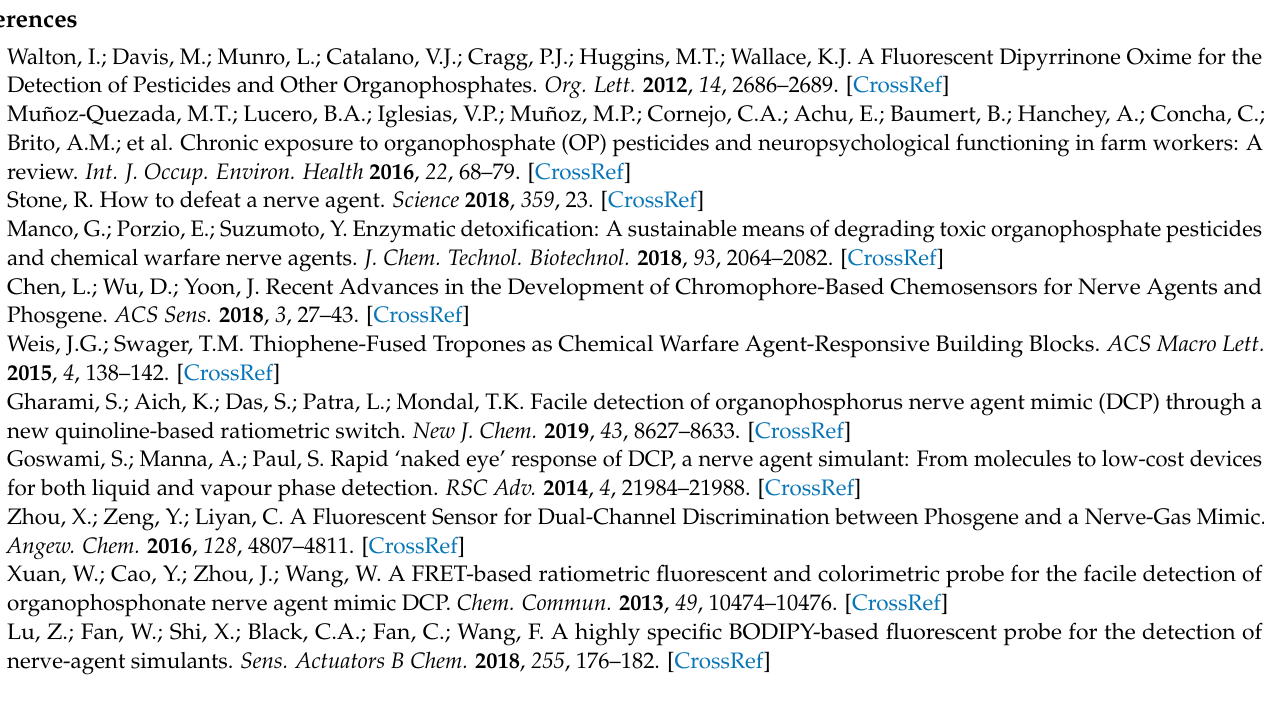
Table S1: Some reported work for the detection of DCP. Figures S1–Figure S3: Copies of 1 H, 13 C NMR, ESI-MS spectra of SWJT-4 . Figure S4: The changes of fluorescence in different solvents. Figure S5: The effect of pH on fluorescence intensity. Figure S6: The linear relationship between SWJT-4 and different concentrations of DCP. Figure S7: Time-dependent experiment of SWJT-4 . Figures S8 and S9: Job’s and Benesi-Hildebrand plots of SWJT-4 with DCP. Figure S10: ESI-MS spectrum of SWJT-4 + DCP. Figure S11: The fluorescence spectrum and absorption spectrum of SWJT-4 calculated by DFT in DMSO and